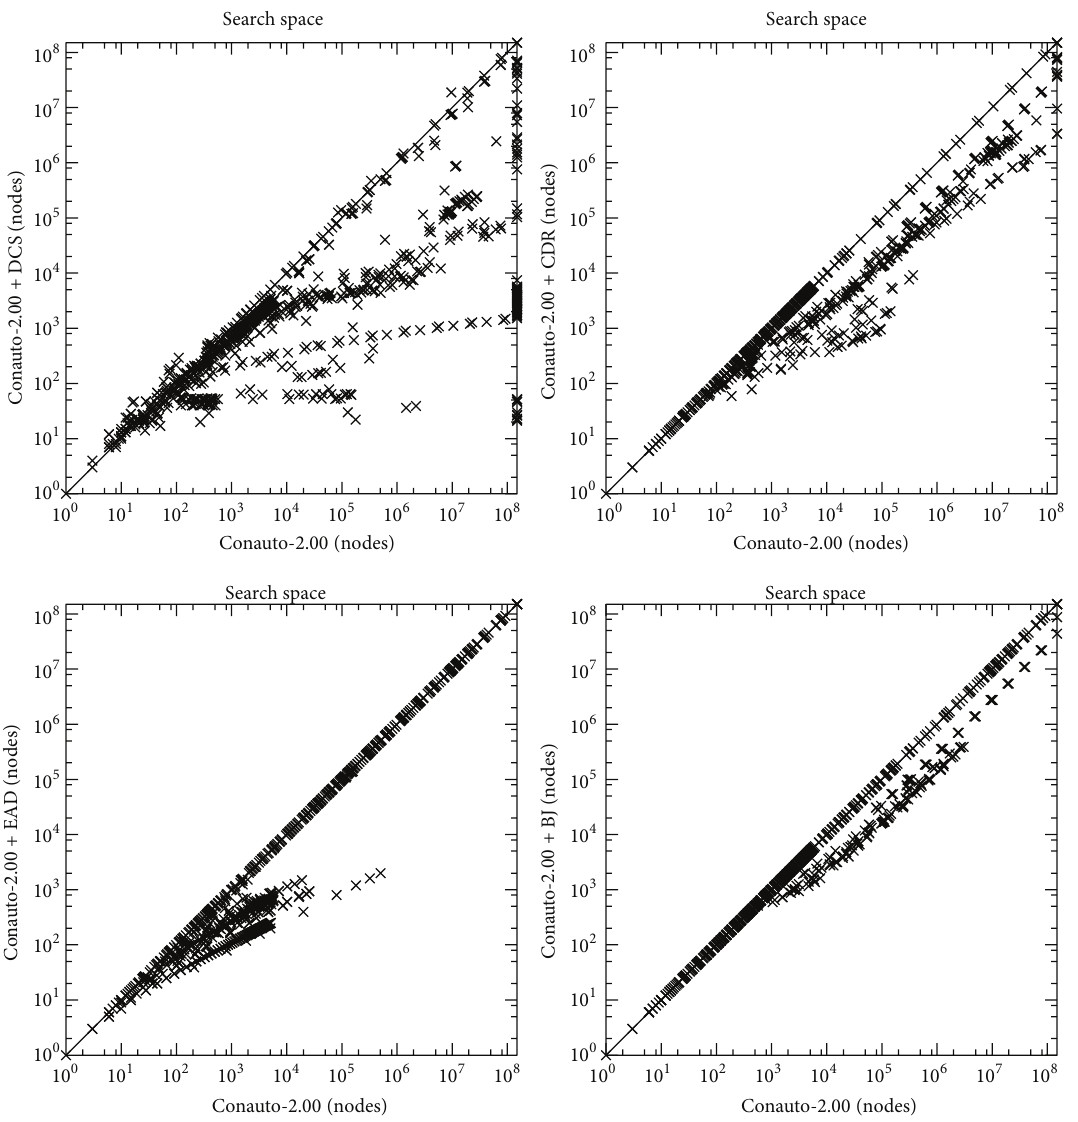
Figure 5: Search-Space comparison for the different techniques in